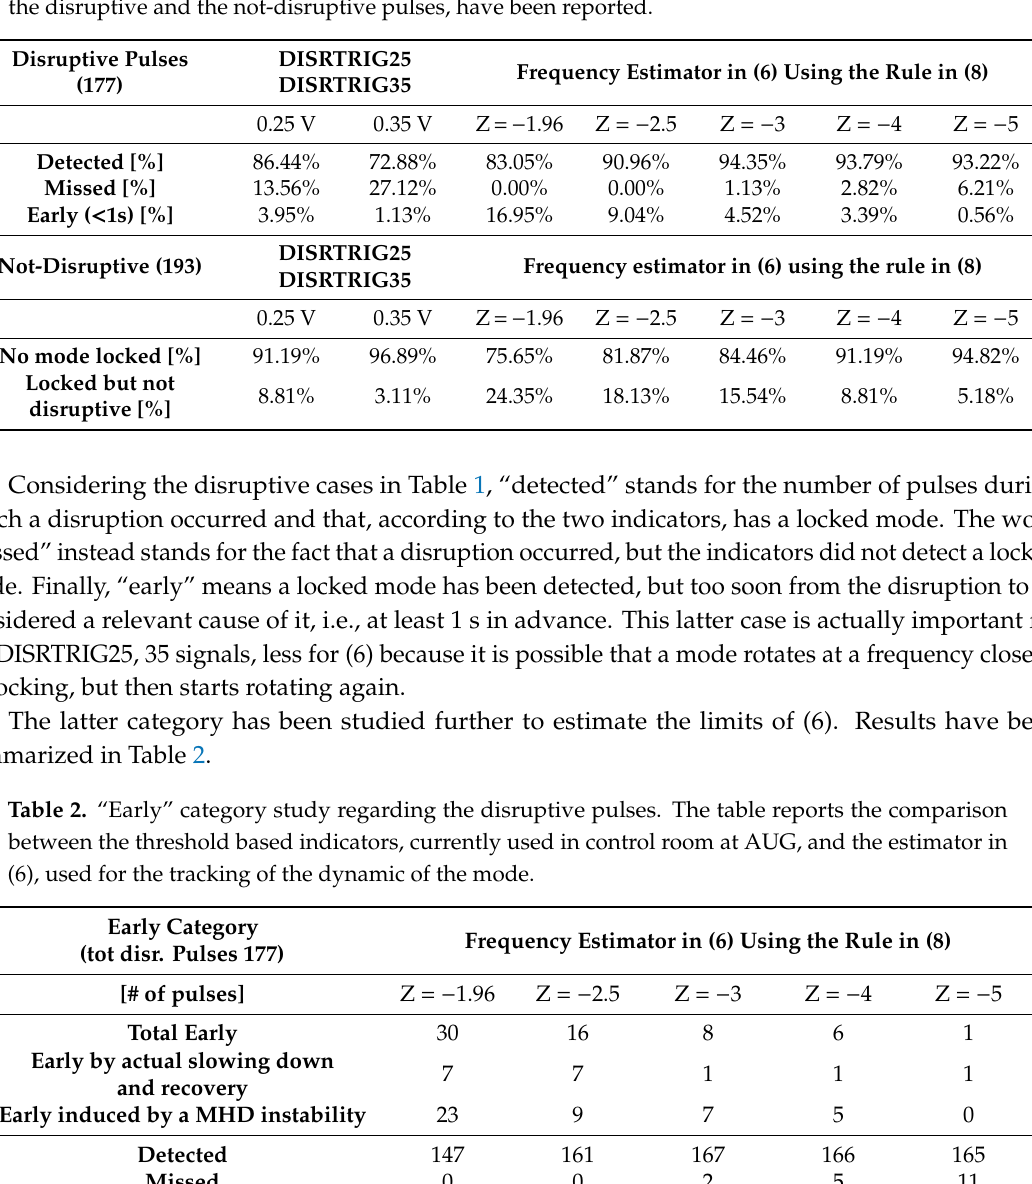
Table 1. Comparison between the threshold based indicators currently used in control room at AUG and the estimator (6) used for the tracking of the slowing down of the mode. Both studies, regarding the disruptive and the not-disruptive pulses, have been reported.